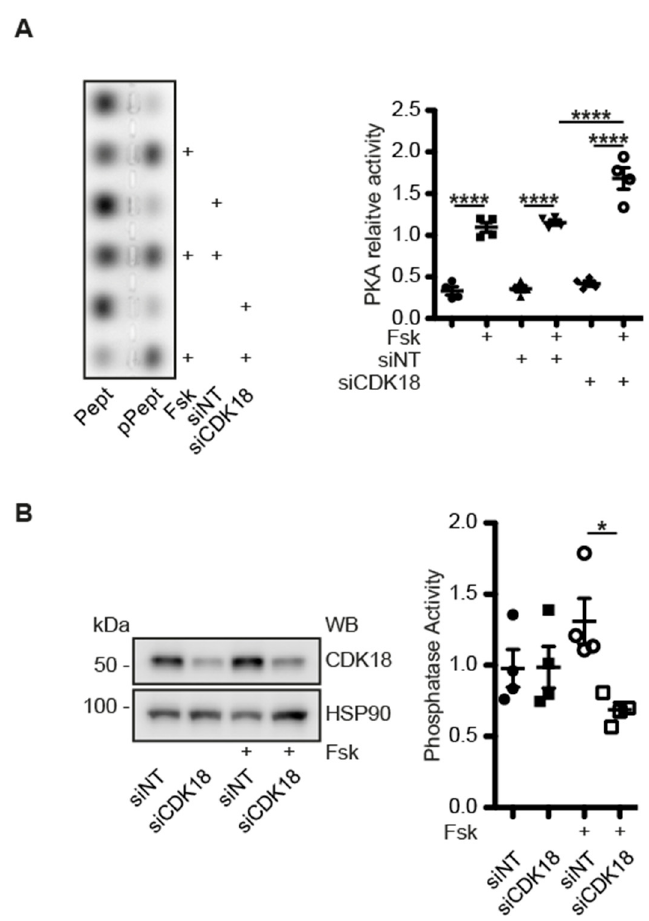
Figure 7. ( A ) MCD4 cells were lysed and PKA activity was determined by measuring its ability to phosphorylate a substrate peptide (PepTag A1). Shown is a representative agarose gels from n = 4 independent experiments with PKA-phosphorylated (pPept) and non-phosphorylated (Pept) PepTag A1 peptide. The amounts of each peptide were semi-quantitatively analysed and relative PKA activity was expressed as the ratio of phosphorylated to non-phosphorylated peptides. ( B ) MCD4 cells were transfected with siNT or CDK18 siRNA, and stimulated with forskolin (Fsk). Phosphatase activity was assayed using para-nitrophenyl-phosphate (pNPP; n = 4). Statistically significant differences are indicated, * p < 0.05, **** p < 0.0001.